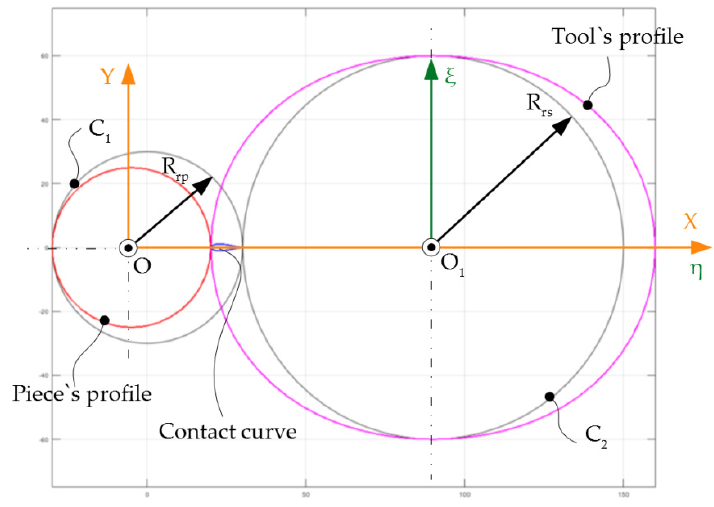
Figure 4. The tool’s profile, the contact curve, and the profile of the piece.